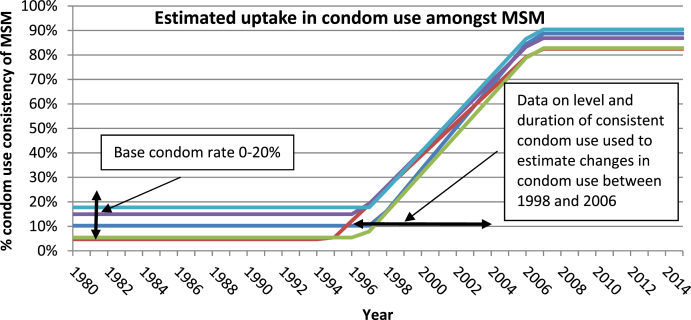
Estimated trends in condom use among MSM.